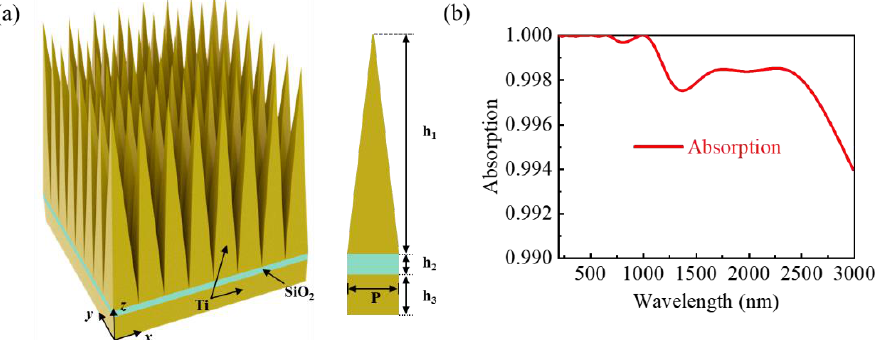
Figure 1. ( a ) Schematic diagram of the designed perfect absorber structure; ( b ) the corresponding absorption spectrum.